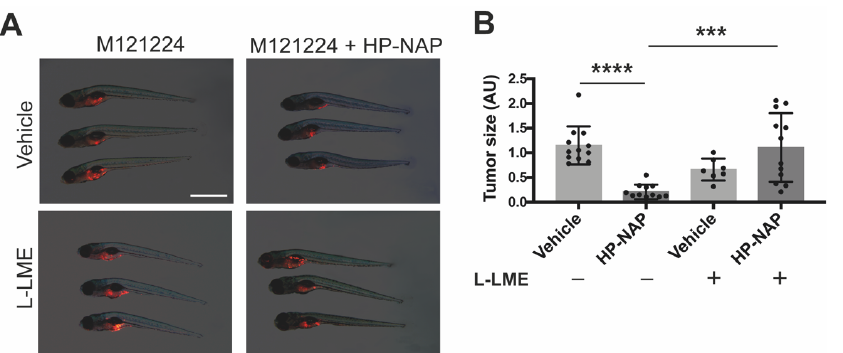
Figure 7. The anti ‐ tumor activity of HP ‐ NAP is strictly dependent on macrophages: effect of macrophage depletion by L ‐ Leucyl L ‐ Leucine Methyl Esther (L ‐ LME). Tg(mpeg1:EGFP)gl22 zebrafish embryos were xenotransplanted with M121224 melanoma cells (red) and treated with saline (vehicle), or L ‐ leucine methyl ester (L ‐ LME), L ‐ LME + HP ‐ NAP or HP ‐ NAP at 2 dpi and observed at 4 dpi. ( A ) Representative fluorescence stereoscope images of the total tumor mass in fishes at 4 dpi. Scale bar, 1 mm. ( B ) Scatter plots show the quantification of the total tumor size (AU: Arbitrary Unit) at 4 dpi. Values are expressed as mean ± SEM and analyzed by one ‐ way ANOVA; ****, p < 0.0001, HP ‐ NAP vs. vehicle ( n = 12 for each condition); ***, p < 0.01: L ‐ LME + HP ‐ NAP ( n = 12) vs. HP ‐ NAP ( n = 12).